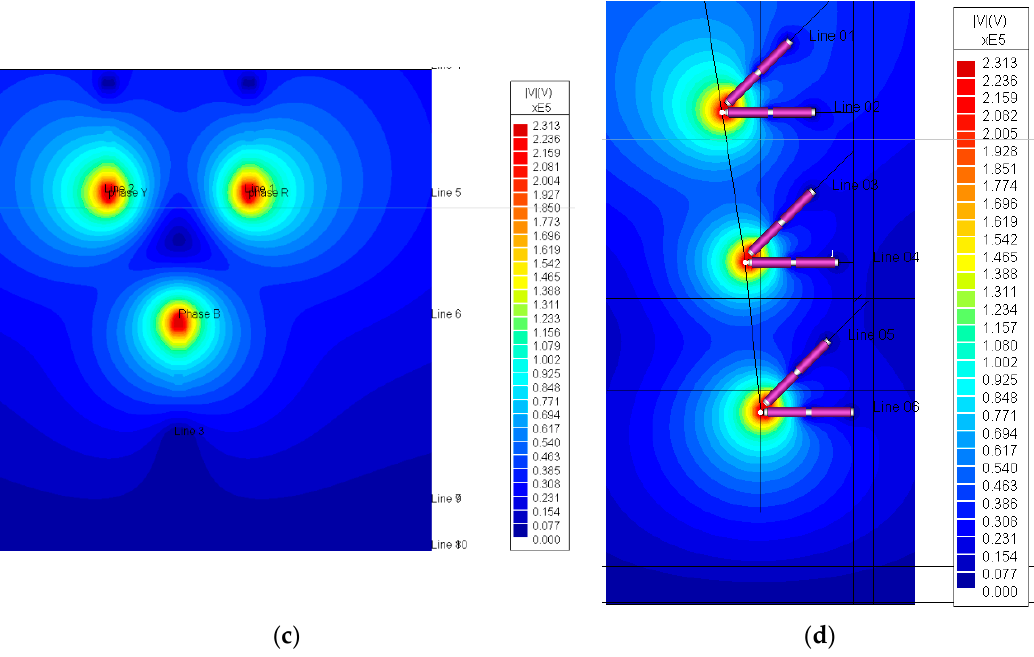
Figure 3. Compact delta ( a ) and vertical ( b ) busbar arrangements and the computed electrical potential on a vertical section ( c ) and ( d ) respectively.